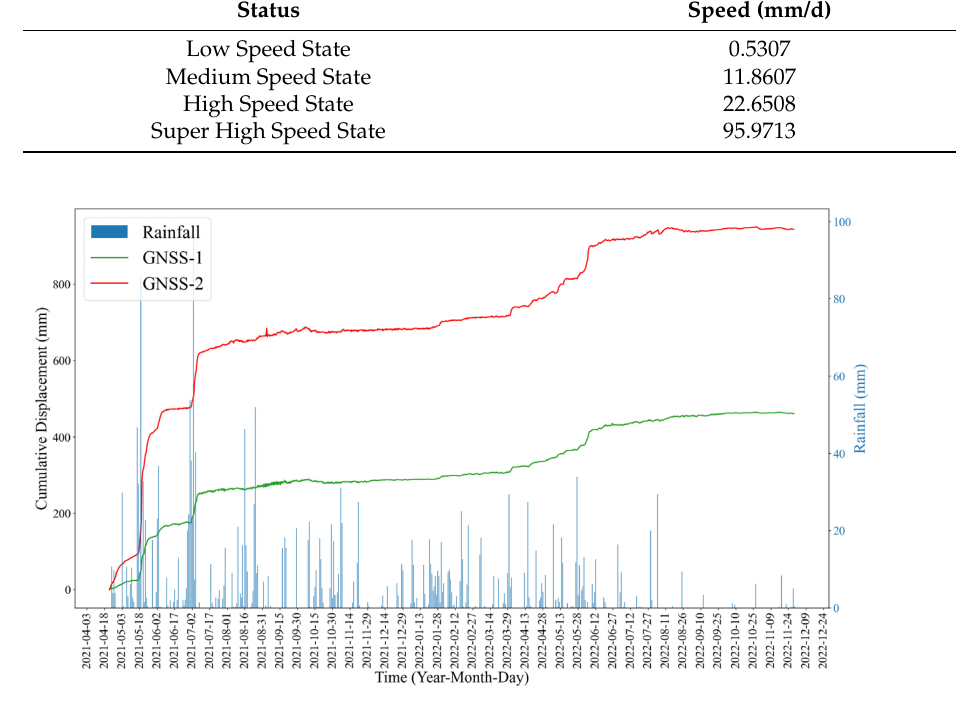
Figure 14. Deformation data and rainfall data of Shangmao landslide.